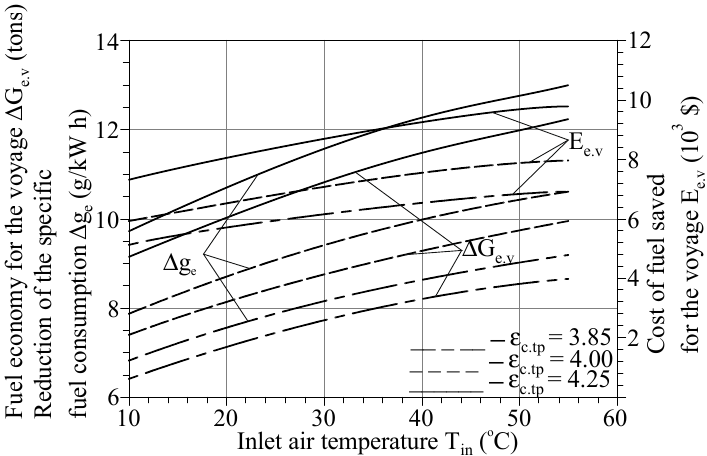
Figure 25. Dependences of the increase in UTG power Δ N utg ; reduction in fuel consumption, Δ G e , reduces the specific fuel consumption, Δ g e , at different total pressure increase, ε c . tp , on the inlet air temperature, T in .